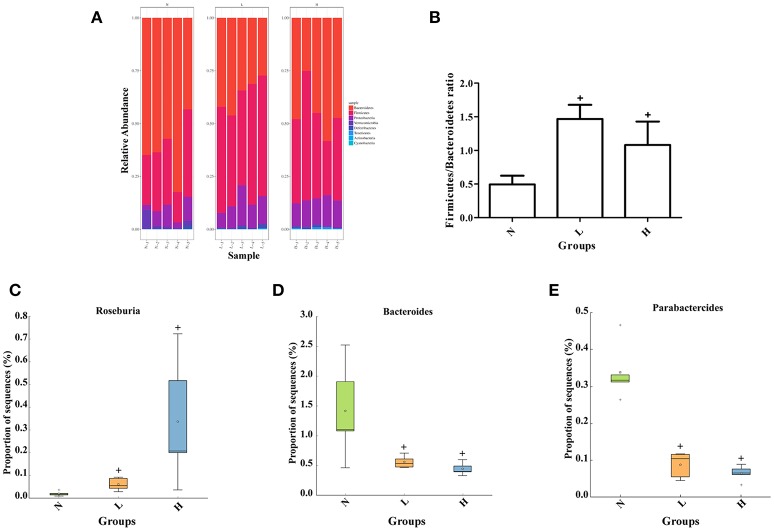
Effect of dietary capsaicin on the gut microbiota composition. (A) Changes in the taxonomic composition of the gut microbiota at the phylum level; (B) the Firmicutes/Bacteroidetes ratio; (C) the abundance of Roseburia; (D) the abundance of Bacteroides; (E) the abundance of Parabacteroides. N, normal diet group (n = 5); L, low-capsaicin diet group (n = 5); H, high-capsaicin diet group (n = 5). Data are shown as box and whisker plots. The box indicates the interquartile range (IQR, 75th to 25th percentiles of the data), and the mean value is shown as a line within the box; whiskers extend to the most extreme value within 1.5 × IQR, and outliers are shown as crosses. The results were analyzed by one-way ANOVA with Tukey's post hoc test or the Kruskal–Wallis test, +P < 0.05.